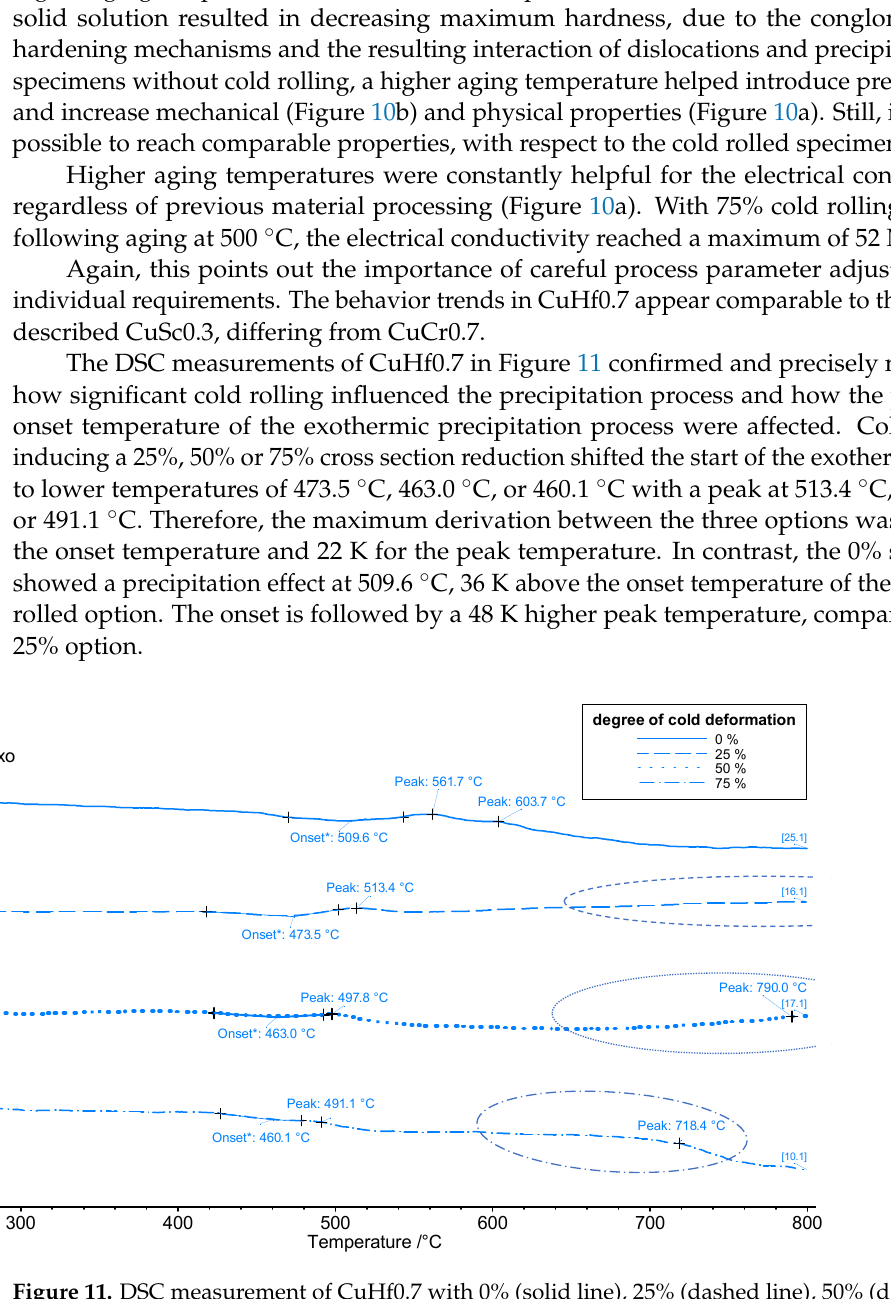
Figure 11. DSC measurement of CuHf0.7 with 0% (solid line), 25% (dashed line), 50% (dotted line), and 75% (dot-dashed line) cold rolling with peak and onset temperatures for the precipitation effect, as well as the area of recrystallization.